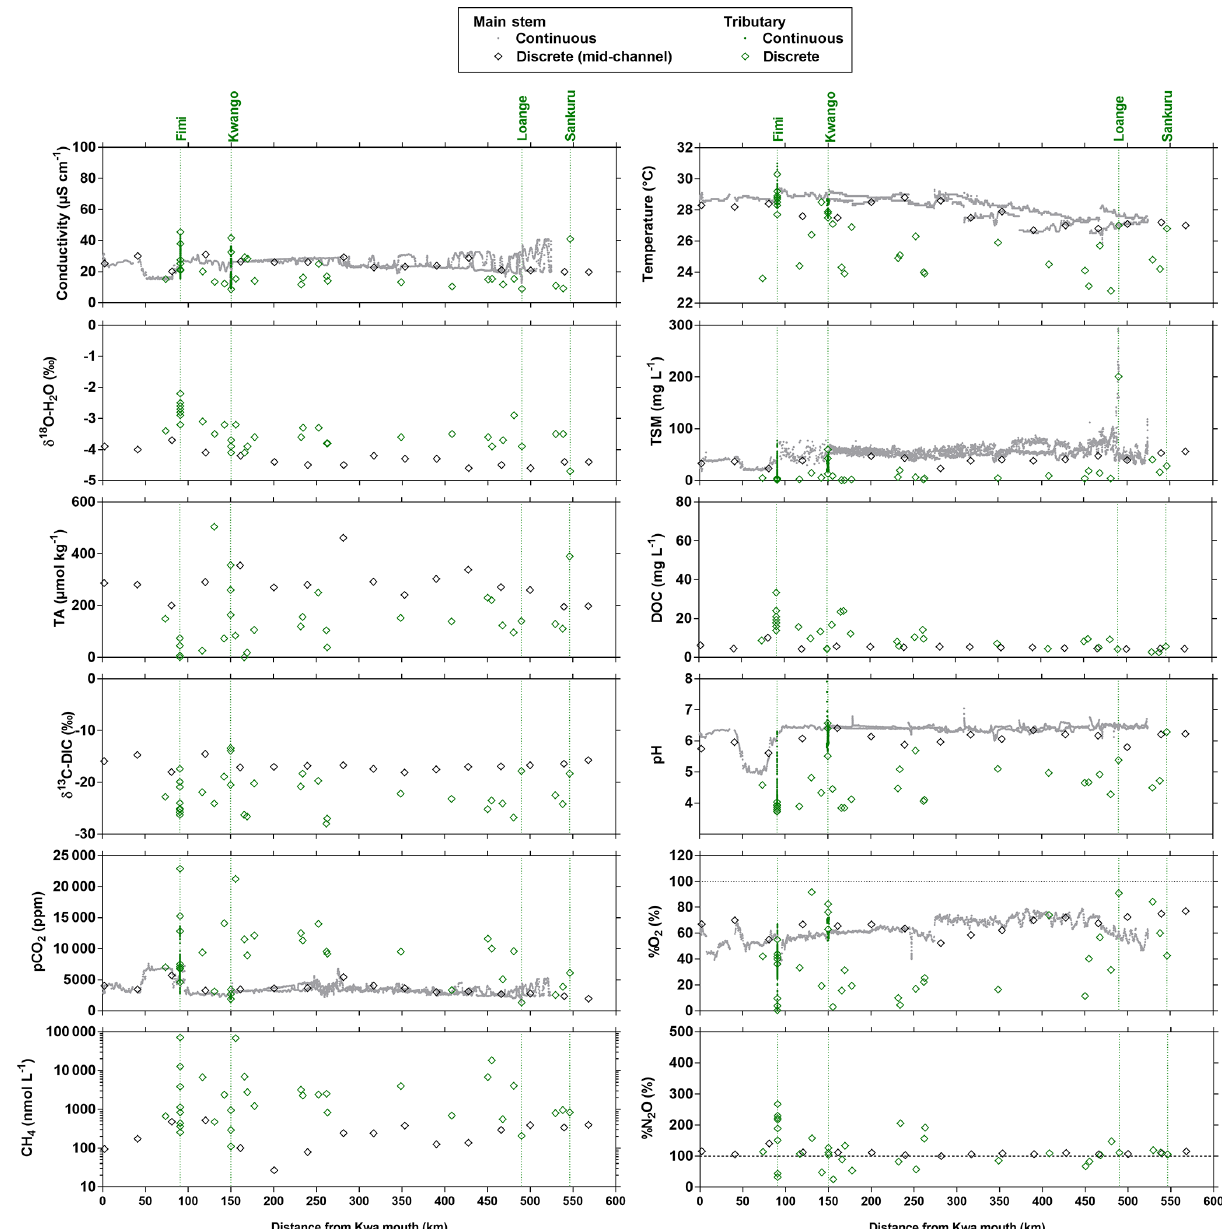
Figure 10. Variation in surface waters of the specific conductivity (µScm − 1 ), water temperature ( ◦ C), oxygen stable isotope composition of H 2 O ( δ 18 O-H 2 O in ‰), total suspended matter (TSM in mgL − 1 ), total alkalinity (TA in µmolkg − 1 ), dissolved organic carbon (DOC in mgL − 1 ), carbon stable isotope composition of dissolved inorganic carbon ( δ 13 C-DIC in ‰), pH, partial pressure of CO 2 ( p CO 2 in ppm), dissolved O 2 saturation level (%O 2 in %), dissolved CH 4 concentration (nmolL − 1 ) and dissolved N 2 O saturation level (%N 2 O in %) as a function of the distance upstream of the Kwa mouth along a transect along the Kwa River (16 April–6 May 2015, n = 7017). Grey and black symbols indicate samples from the main stem and green samples from